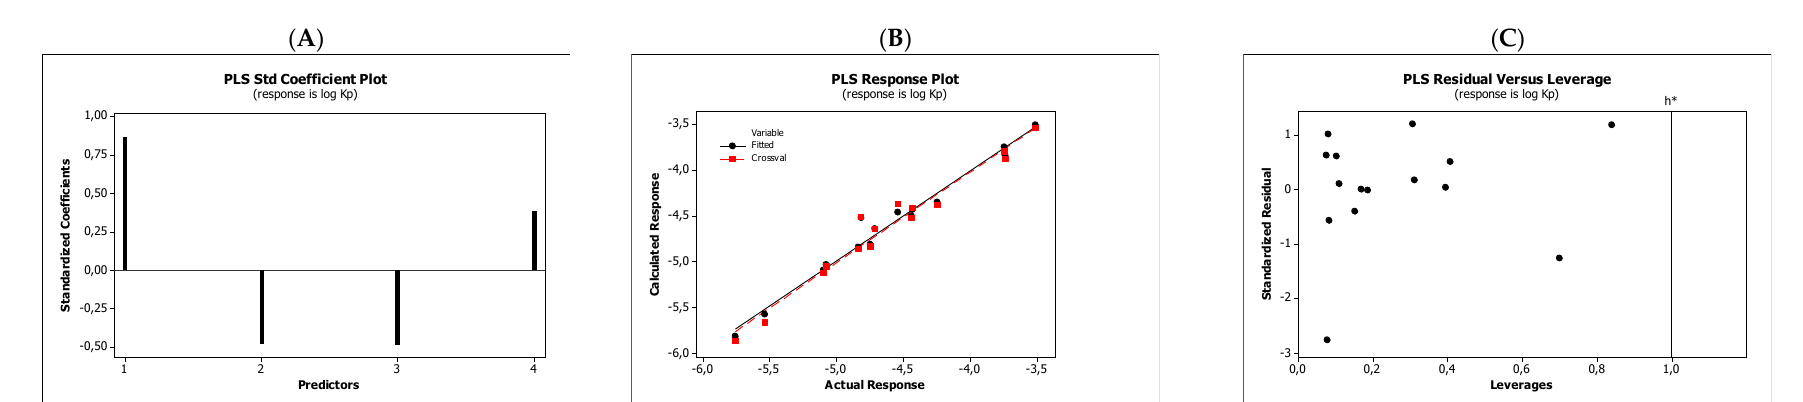
Figure 4. Standardized coefficients ( A ), the correlation between actual and predicted log K p parameters ( B ), and the Williams plots ( C ) of Equation (3).